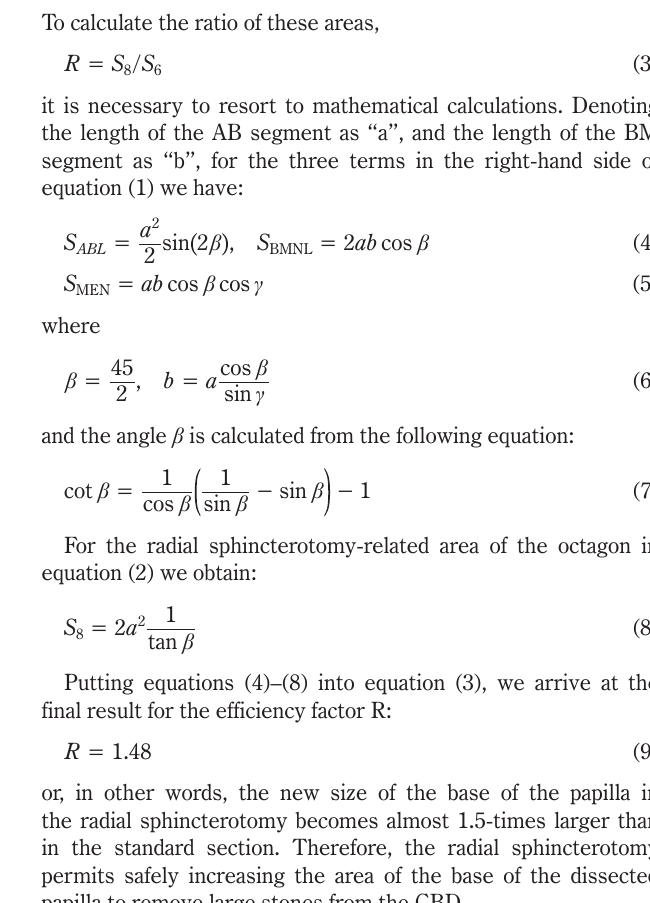
Figure 4 Maximum area in an incision for a standard sphincterotomy.